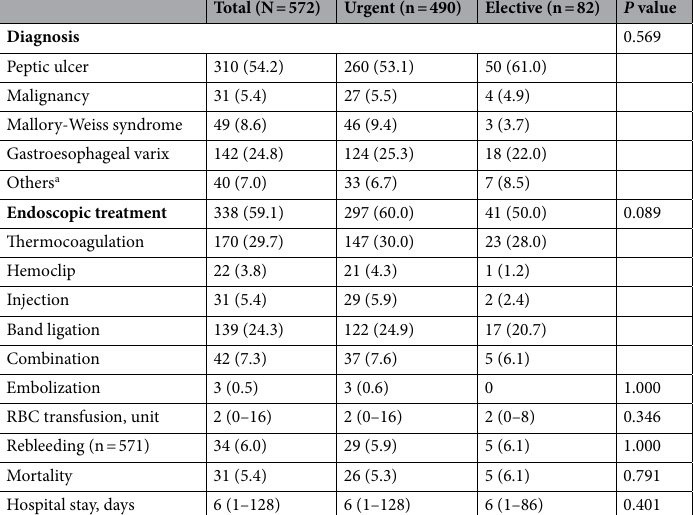
Table 2. Endoscopic findings and clinical outcomes. a Others include marginal ulcer, acute gastric mucosal lesion, angioectasia, tuberculosis, esophageal ulcer, jejunal ulcer, gastrointestinal stromal tumor, and neuroendocrine